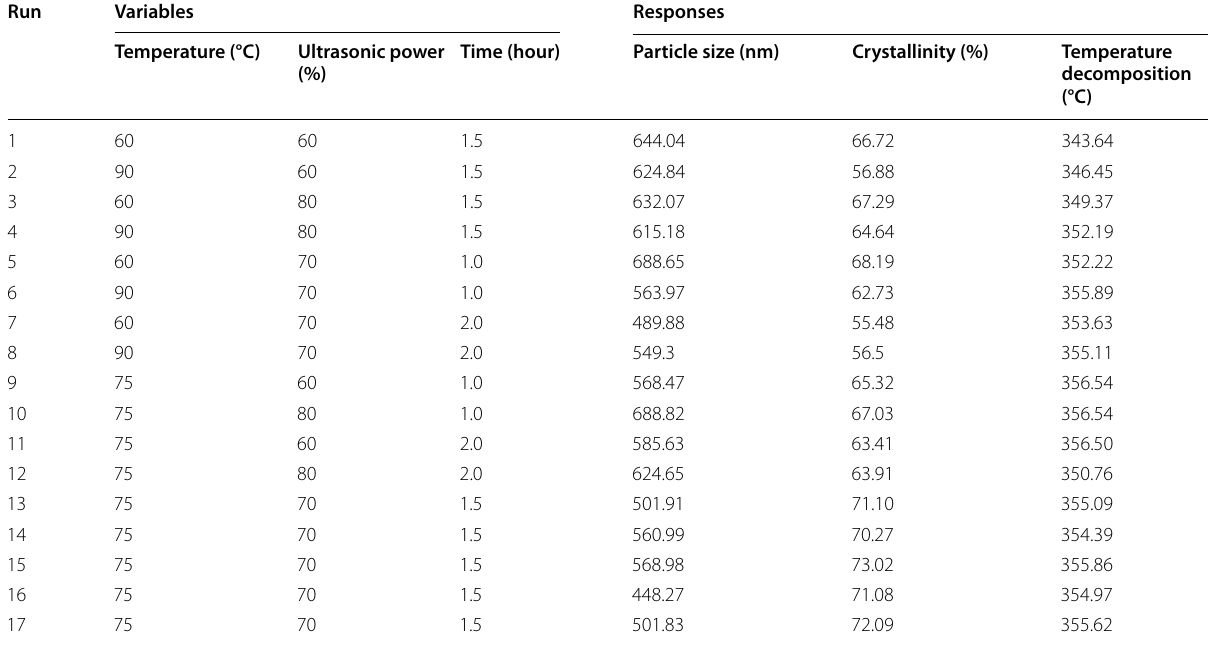
Table 1 Effect of ultrasonic-homogenizer treatment on particle size, crystallinity, and thermal properties of GAP waste Run